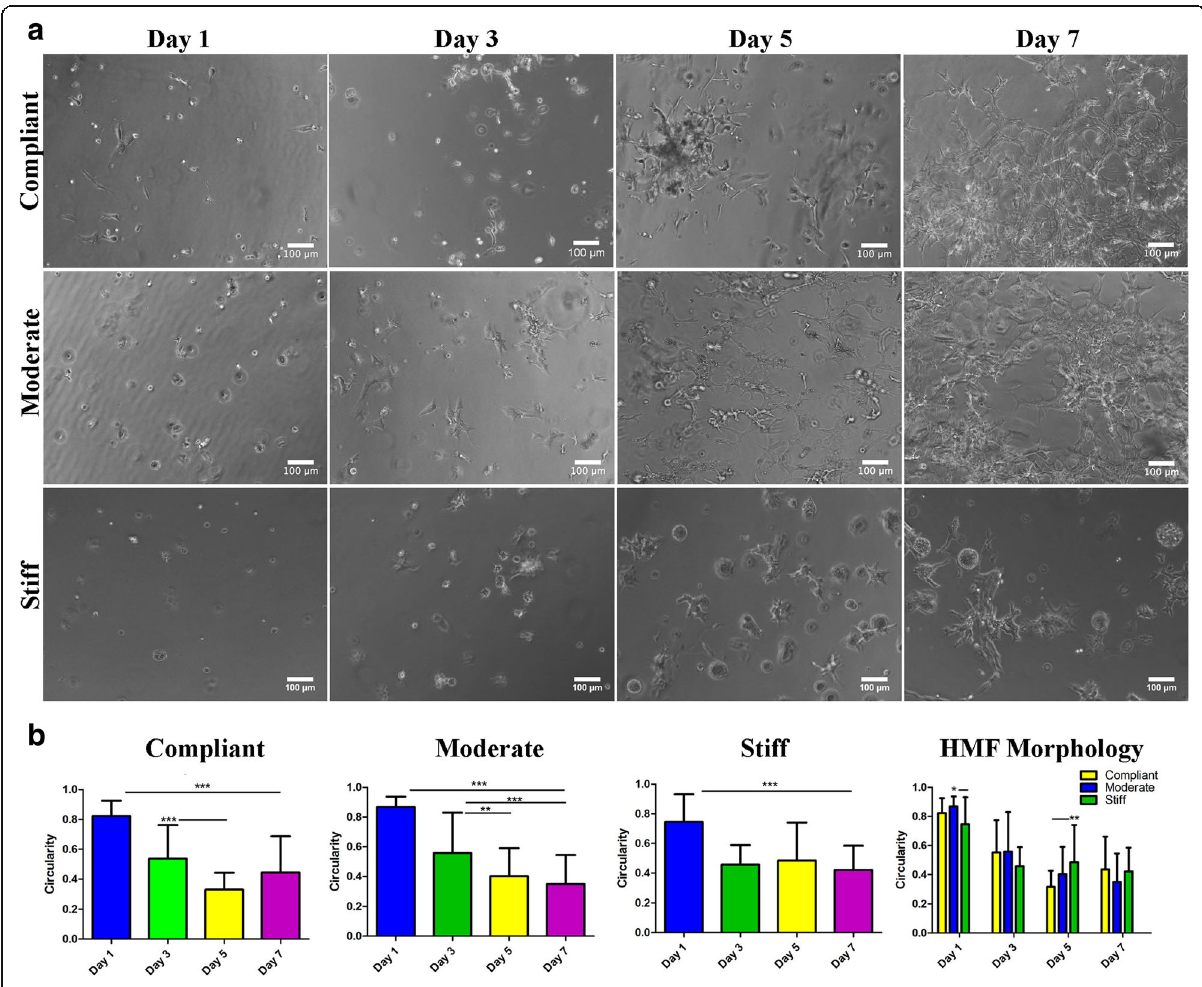
Fig. 3 HMF morphology in mTG hydrogels. a HMFs encapsulated in compliant, moderate and stiff hydrogels were examined for differences in cell morphology during the culture period. At day 1, HMFs in all tested mTG concentrations appeared rounded and started to spread, forming elongated spindle-like morphologies at day 3. At day 5, HMFs in compliant and moderate hydrogels assumed a more spindle-like morphology while HMFs in stiff hydrogels appeared to have a larger cell body with thicker cellular protrusions. After 7 days in culture, HMFs in compliant and moderate hydrogels retained their spindle-like morphology from day 5, but occupied a greater area of the hydrogel. HMFs in stiff mTG hydrogels still exhibited a large cell body with multiple large cellular protrusions at day 7, an observation similar to that for day 5. b HMF morphology was quantified based on the circularity where 0 indicates an elongated structures and 1 indicates a perfect circle. Overall, HMFs became more elongated during the culture period in each of the mTG hydrogels. For stiff hydrogels, HMF morphology didn ’ t change much after day 3 of culture. Comparing hydrogel conditions, HMFs were more elongated in stiff hydrogels at days 1 and 3, compliant hydrogels at day 5 and moderate hydrogels at day 7. * p ≤ 0.05; ** p ≤ 0.01; *** p ≤